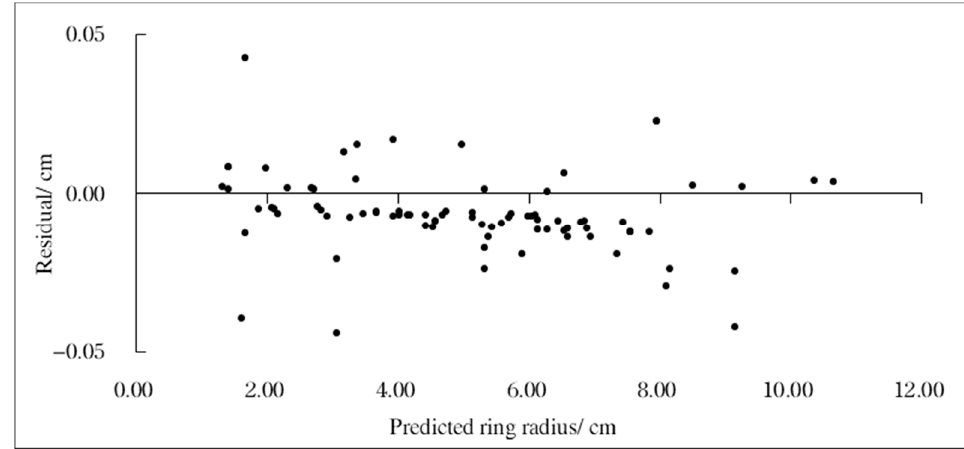
Figure 9. Residual diagram of polynomial regression correction model after heteroscedasticity correction.